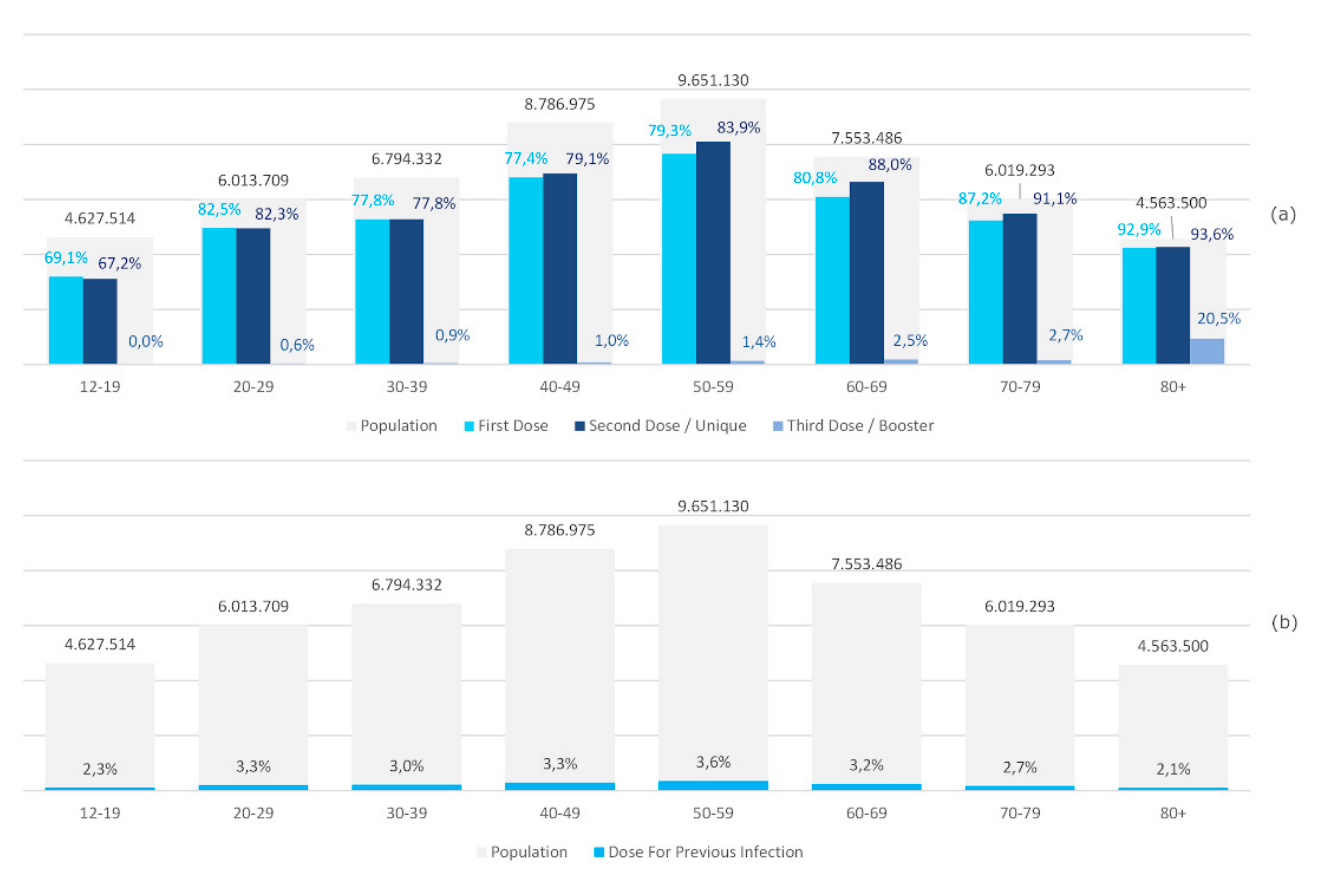
Figure 6. ( a ) Percentages of vaccine administered in the Italian population, stratified by age group and reference population: first, second, and third doses. ( b ) Percentage of doses administered according to previous COVID-19 infection in Italian population, stratified by age group and reference population. The second vaccine doses include the single Janssen doses and single doses of the vaccine carried out on people who have contracted COVID-19. (For this reason, in some cases, the coverage percentage of the second dose exceeds that of the first.)